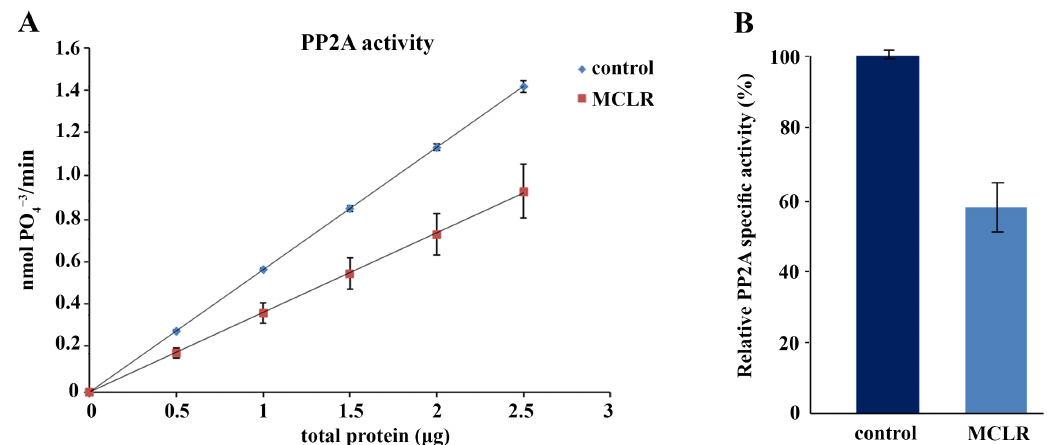
Figure 1. Effects of microcystin-LR (MCLR) exposure on protein phosphatase 2A (PP2A) activity. ( A ) PP2A activity was measured in control and larvae exposed to 500 µ g/L of MCLR, as